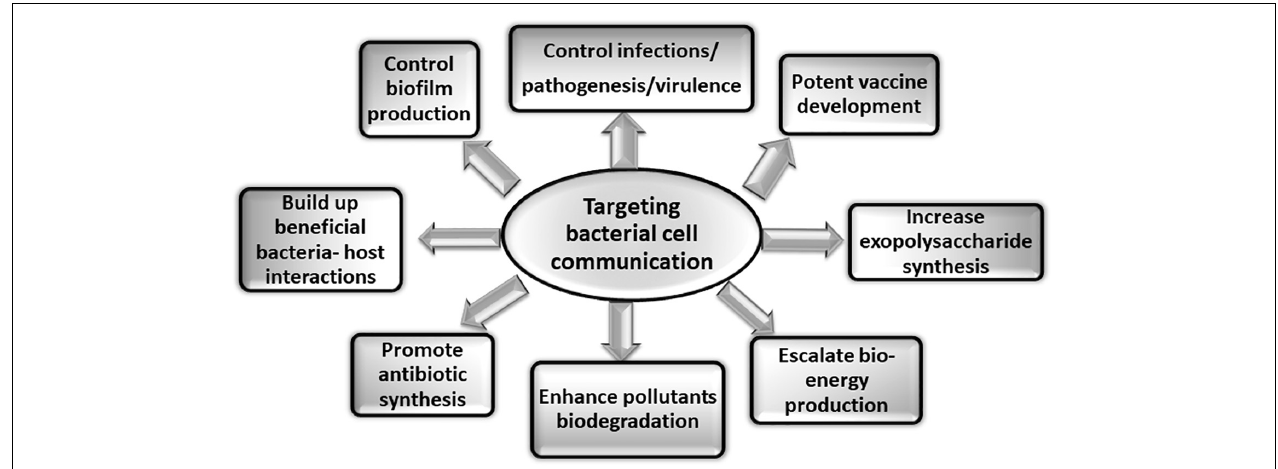
FIGURE 4 | Applications of targeting bacterial cell communication. Studies targeting the various aspects of bacterial cell communication system are of immense importance. The figure shows some of the applications that can be explored by addressing bacterial communication systems.